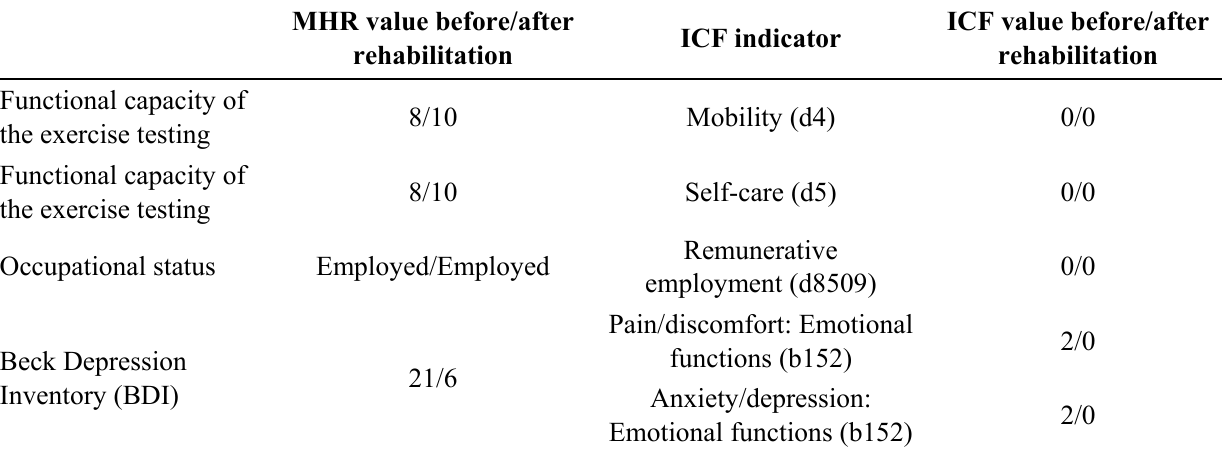
Table 3. Juan’s case: 59-year-old man who participates in motor and psychological rehabilitation processes (walking and psychotherapy) during 157 days.